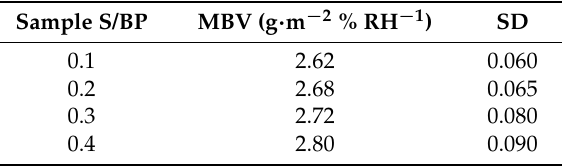
Table 6. Moisture buffer values of S-BP